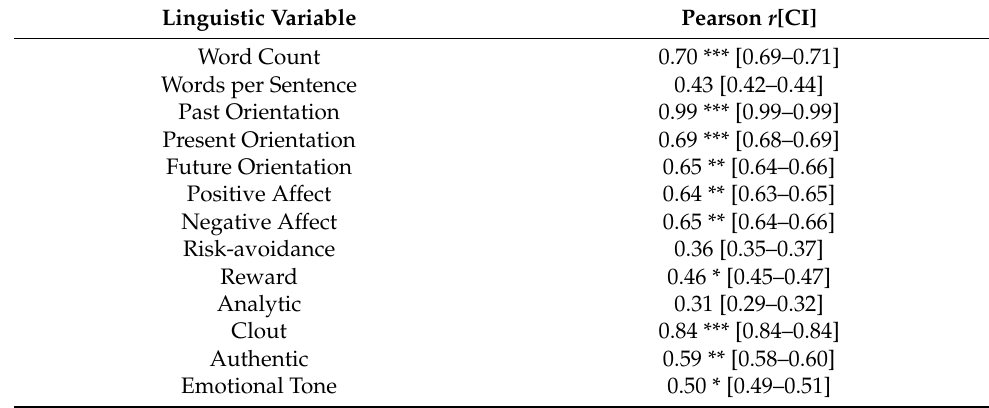
Table 2. Correlation matrix for EFT-Events Raw vs. EFT-Events Brief linguistic variables.